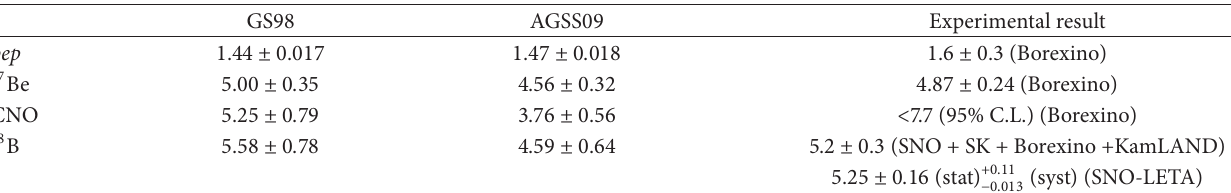
Table 6: Comparison between the SSM predictions for the solar neutrino fluxes with high (GS98) and low metallicity (AGSS09) and the experimental results. The CNO flux corresponds to the sum of the 13 N, 15 O, and 17 F solar neutrino